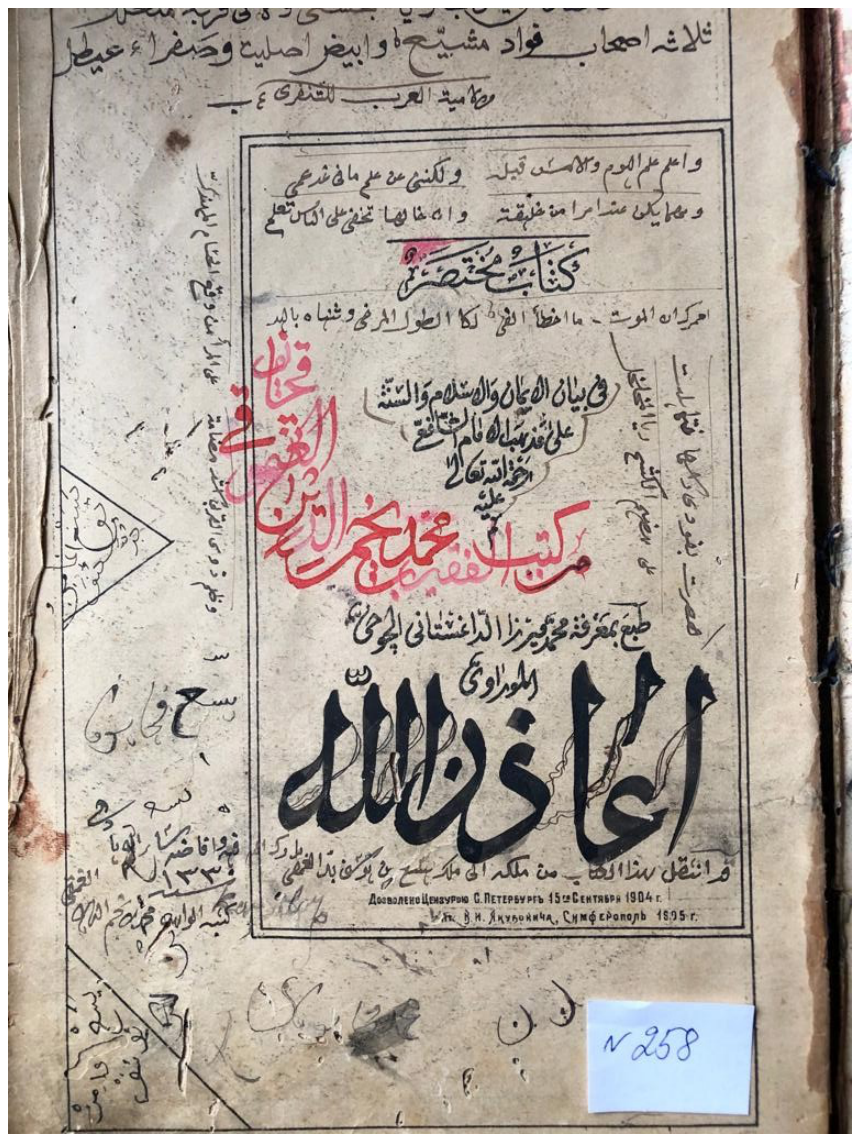
Figure 1 - Muhtasar fi Bayan al-Iman va-l-Islam va-s-Sunnah DOI: